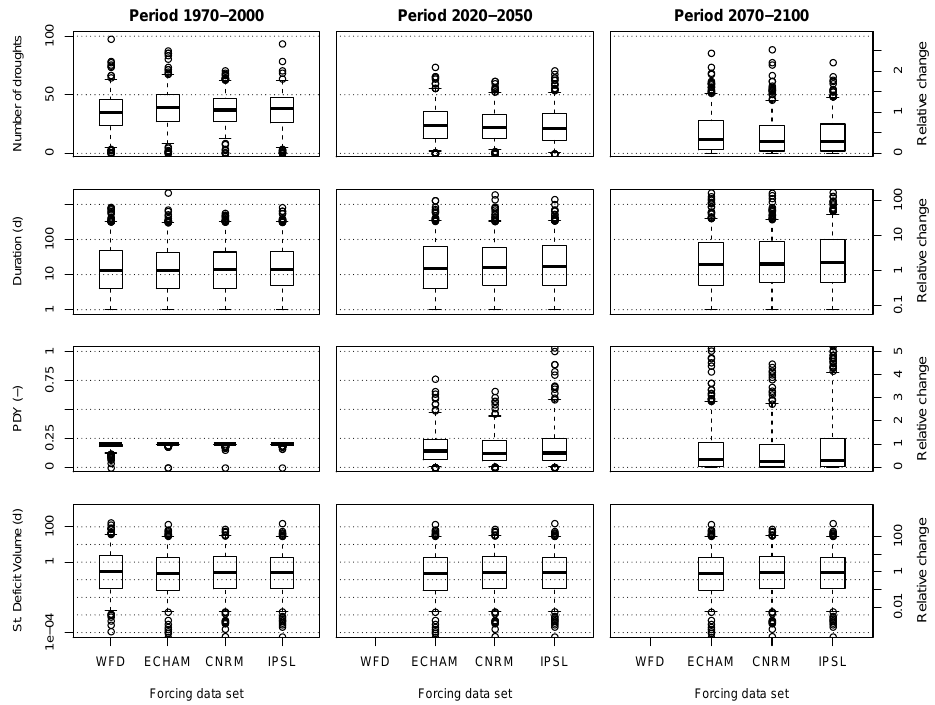
Figure 7. Distribution of three groundwater discharge drought characteristics obtained from a conceptual hydrological model using mete- orological forcing from the WATCH Forcing Data (reference model) and three models with meteorological forcing from GCMs (ECHAM, CNRM and IPSL) for the control period (1971–2000). Row one indicates the number of hydrological droughts per evaluation period, row two the average drought duration (logarithmic scale), row three the percentage of the year in drought and the last row gives the average standardized deficit volume (logarithmic scale).